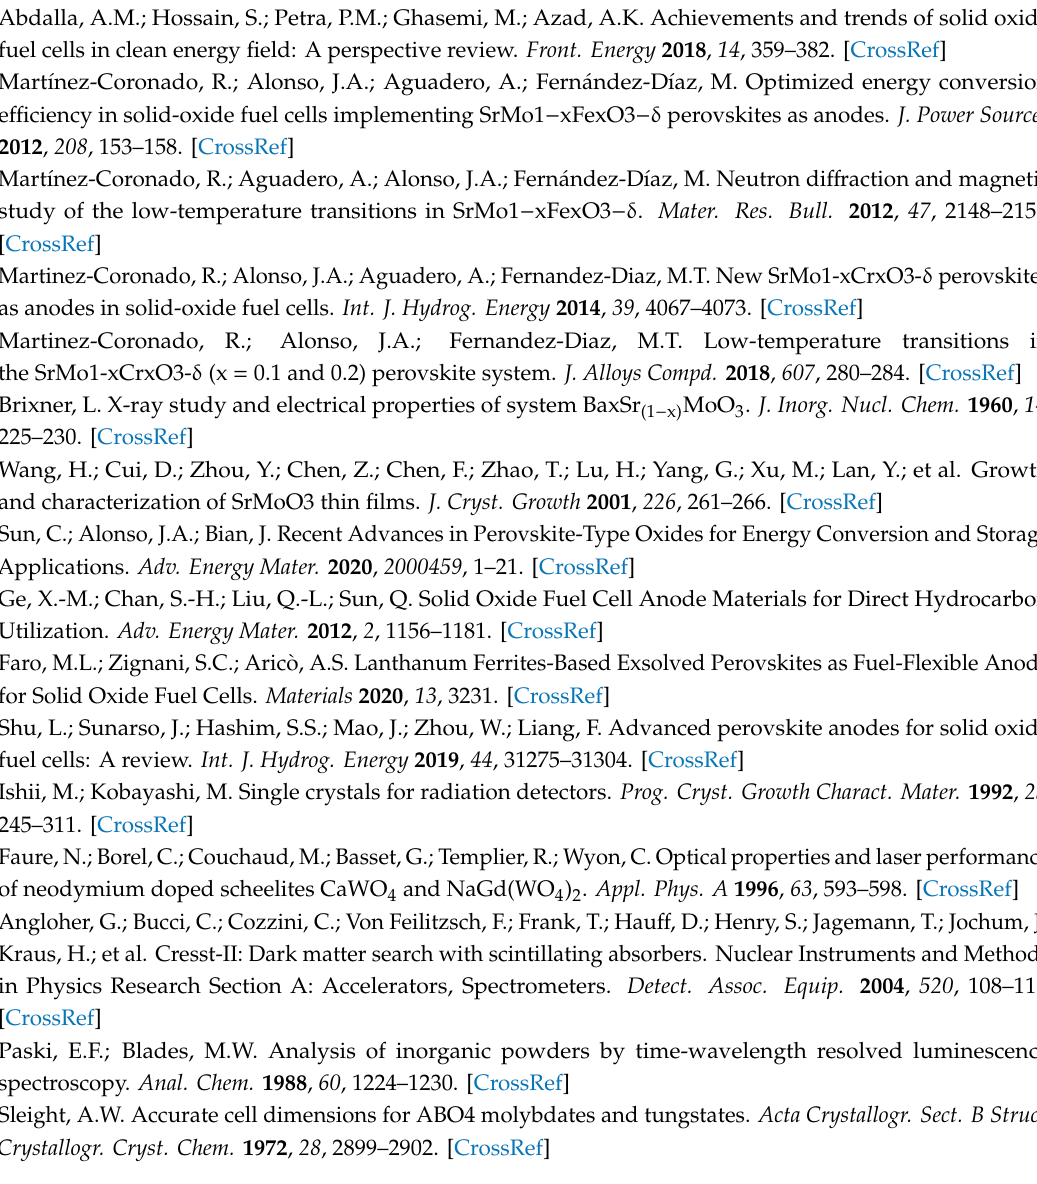
Figure S1: XRD patterns with Cu K α radiation for SrMoO 4 and SrMo 1-x M x O 4- δ (M = Fe and Cr; x = 0.1, 0.2), characteristic of pure tetragonal scheelite phases, Table S1: Unit-cell parameters for SrMo 1-x M x O 4- δ defined in the in tetragonal I4 1 / a (No 88) space group, Z = 4, from XRD at 25 ◦